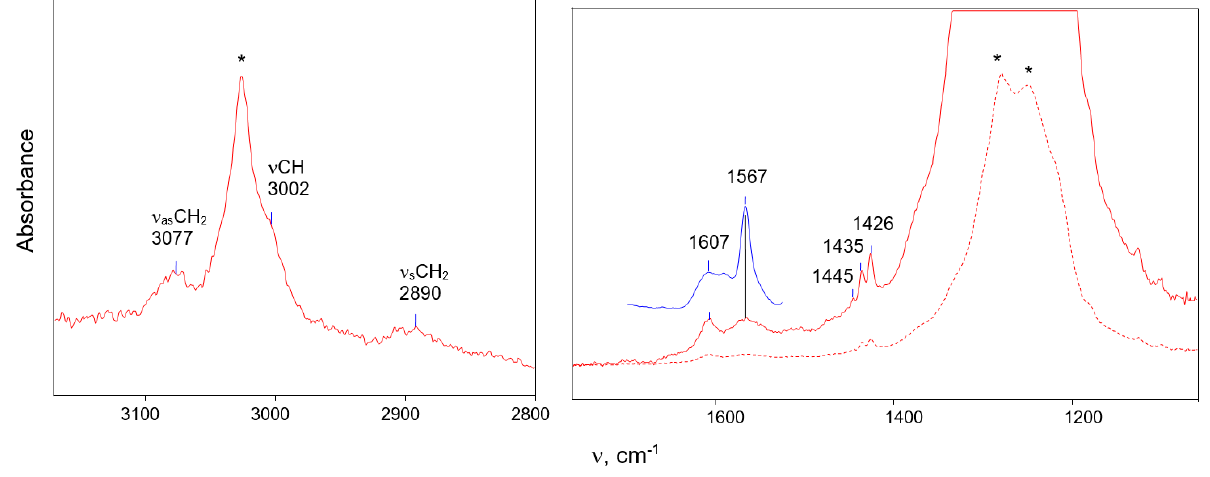
Figure 6. The ATR IR spectrum of the (C 2 H 3 ‐ Cl + ‐ C 2 H 3 ) {F 11 − } salt (red) and the same reduced by a factor of 5 along the vertical axis to show the absorption of C ‐ F vibrations of the anion (dashed curve). The spectrum of the salt after heating at 100 °C for the C=C stretch region is highlighted in blue. Asterisks denote bands of the {F 11 − } anion.